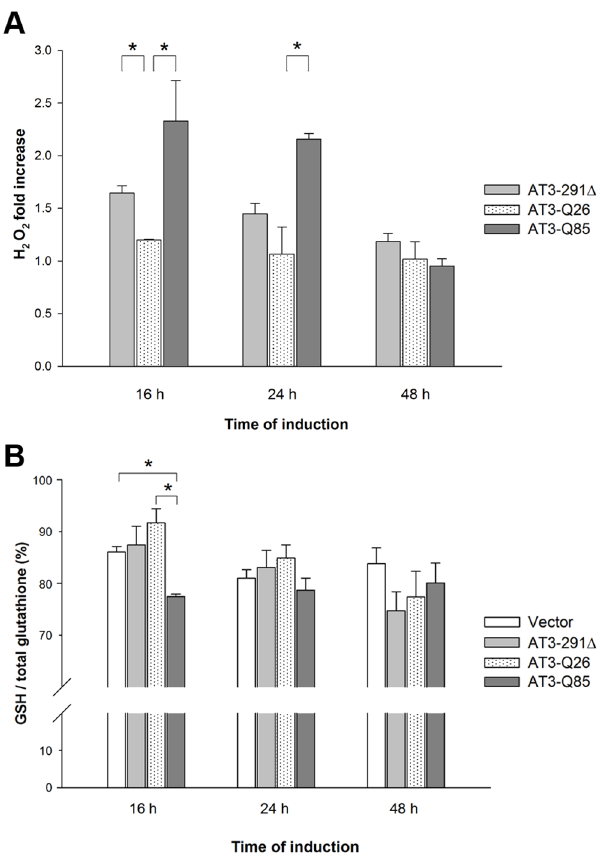
Fig 4. Oxidative stress level in cells expressing AT3 variants. A) ROS levels: intracellular H 2 O 2 levels were determined using the Red Hydrogen Peroxide Assay Kit. The conversion of red peroxidase substrate to resorufin was determined by measuring the absorbance at 576 nm. Data were expressed as fold increase with respect to the empty vector strain level. Bars represent standard errors and are derived from at least three independent experiments (P < 0.05). B) Glutathione levels: GSH and total glutathione content was determinate using the Ellman reagent. Data were expressed as the ratio of GSH to total glutathione content in percentage. Bars represent standard errors and are derived from at least three independent experiments (P <